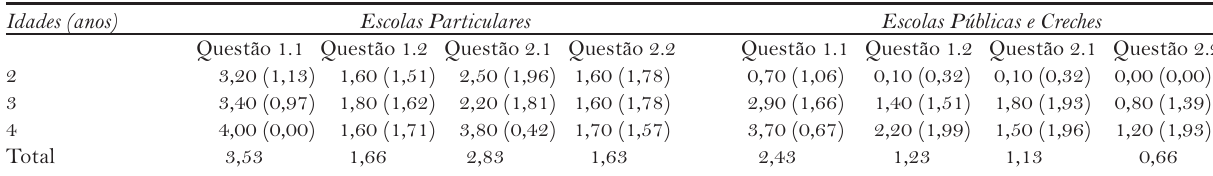
Médias de Acertos Obtidos pelas Crianças em cada Questão em Função da Idade e do Tipo de Escola Idades (anos)